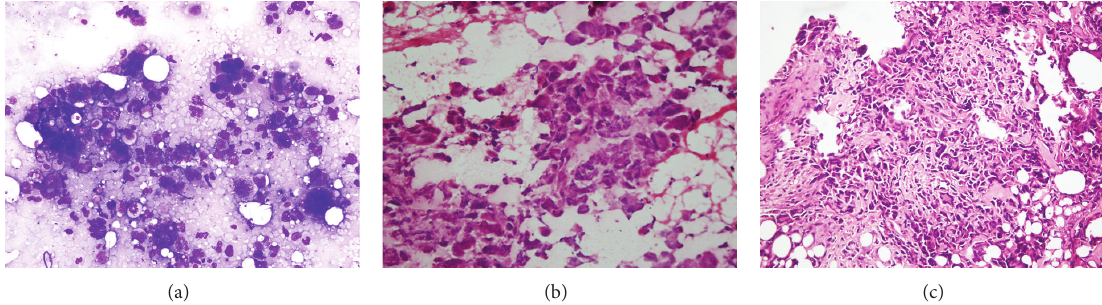
Figure 1: (a–c) Osteosarcoma: (a) highly pleomorphic and bizarre tumor cells on imprint smear (MGG stain, × 100); (b) frozen section showing highly anaplastic tumor cells with pale eosinophilic osteoid formation (H&E, × 400); (c) paraffin-embedded section showing pleomorphic and polymorphic tumor cells directly laying down osteoid (H&E, × 200).